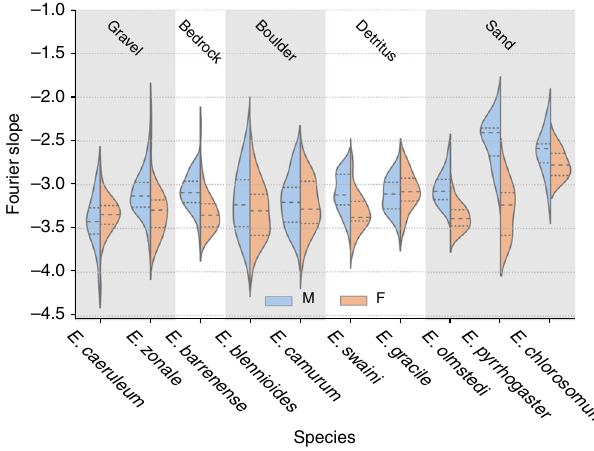
Fig. 4 Distribution of Fourier slopes for males and females of ten species of Etheostoma . Dashed lines represent the median for each group, and dotted lines represent the interquartile range. Shaded areas represent the kernel-density estimate for each sex within each species. The left (blue) half of each violin plot are values for males (total n = 288); the right (orange) half of each violin plot are values for females (total n = 262). Species are grouped by habitat type.